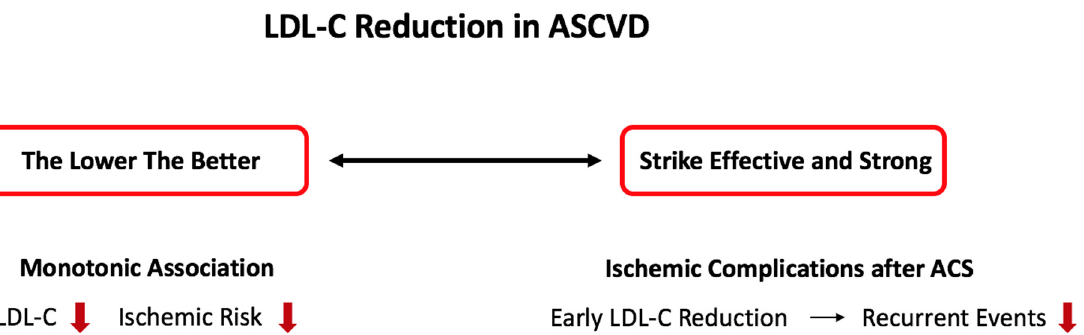
Figure 2. Treatment strategies in lipid-therapy: “the lower, the better” and “strike effective and strong”. ACS: acute coronary syndrome, ASCVD: atherosclerotic cardiovascular disease, LDL-C: low-density lipoprotein cholesterol.